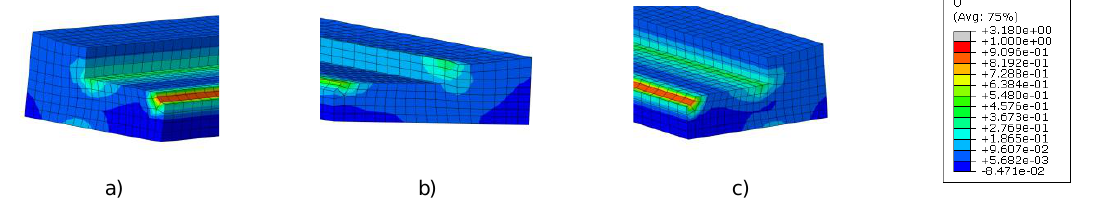
Fig. 5 Deformation energy density [J / mm³] in the cross section of the L-shaped adhesive joint (long side a), corner b), short side c)).